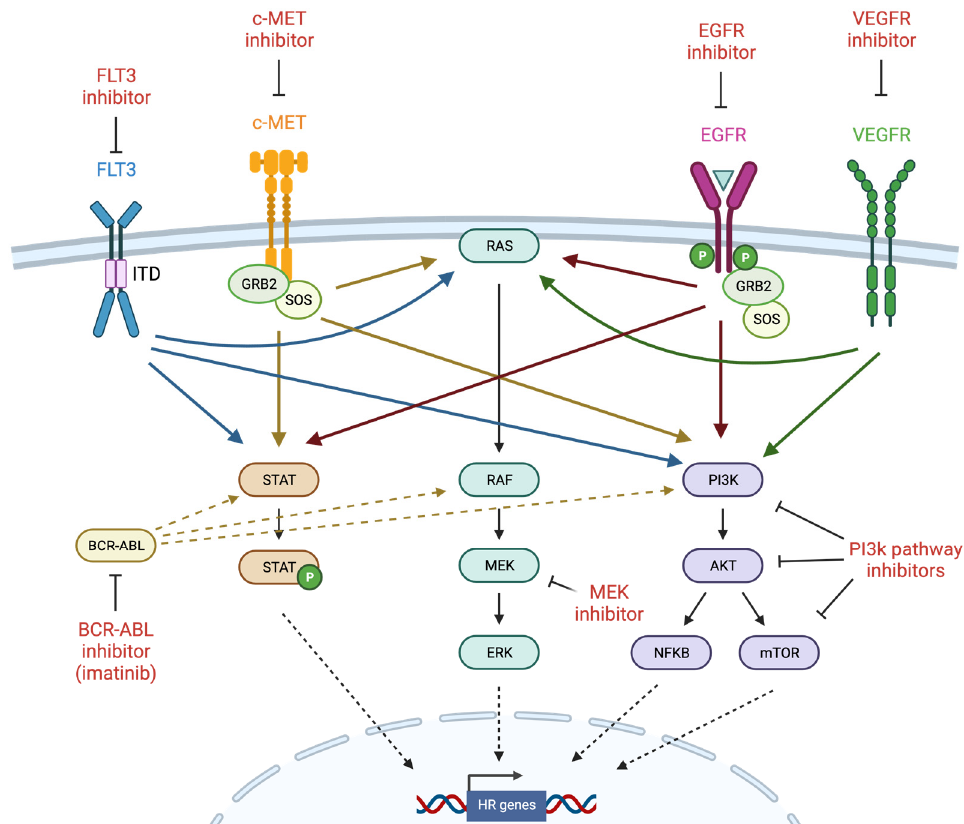
Figure 3. Induction of BRCAness by tyrosine kinase inhibitors (created with Biorender.com, ac- cessed 15th May 2022). Receptor tyrosine kinases (RTKs) such as FLT3, c-MET, EGFR, and